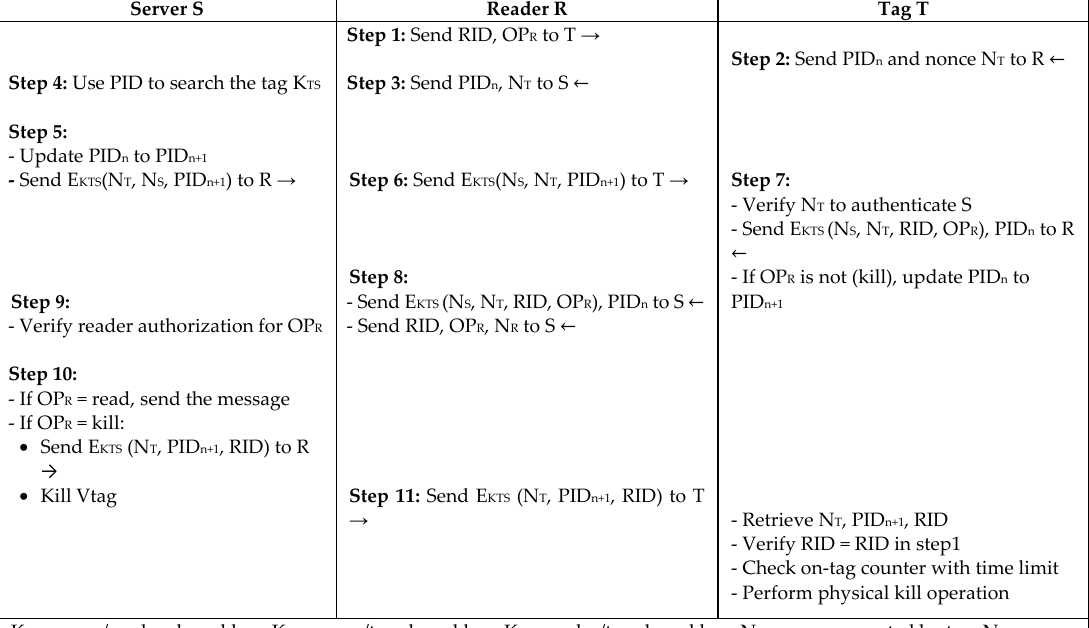
Figure 3. Session-Based Authentication Protocol (SB-B) by Wang and Sarma.